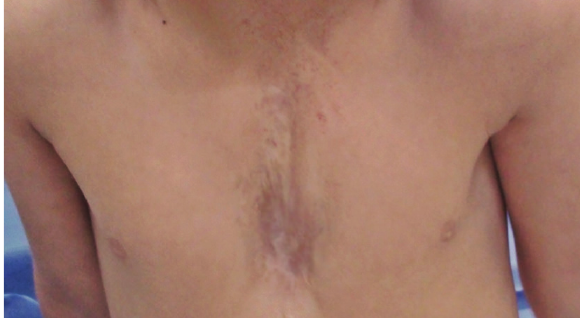
Figure 5: Cosmetic result after surgical reconstruction of anterior wall